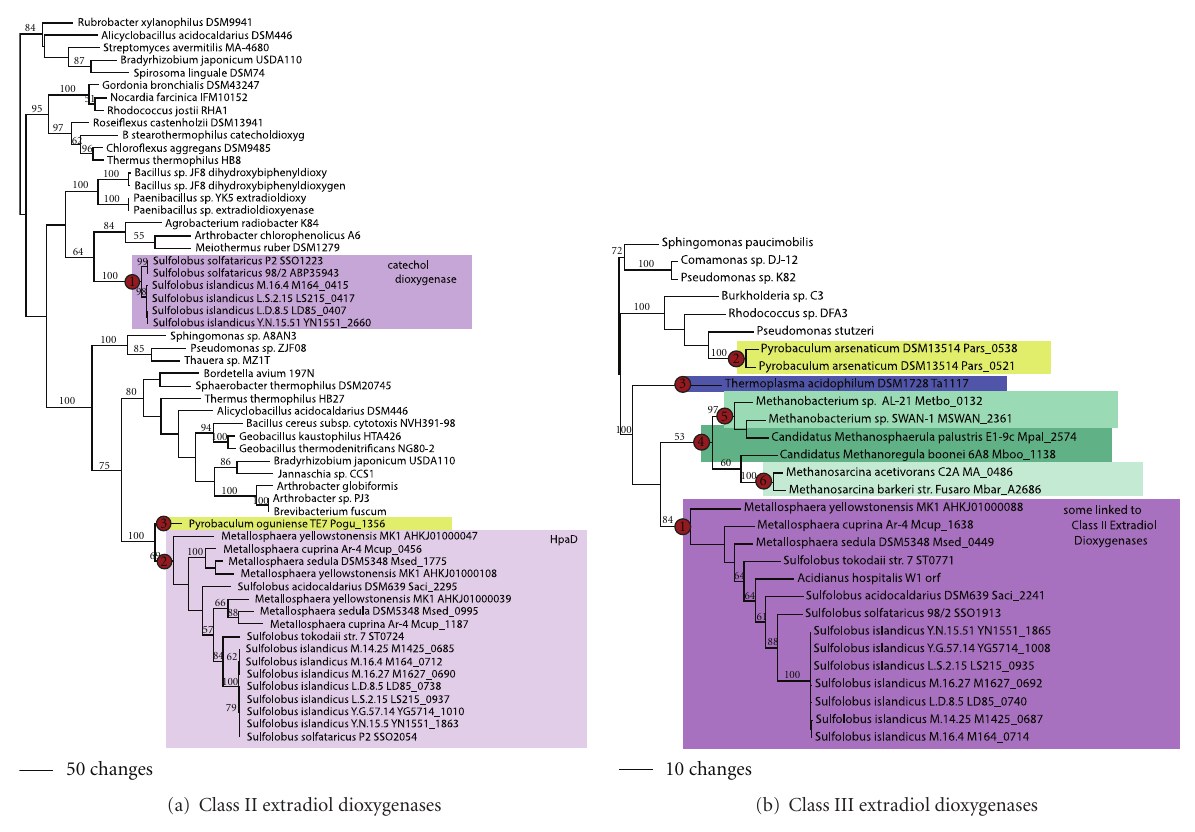
Figure 15: Extradiol dioxygenases. Phylogenetic trees for (a) class II extradiol dioxygenases and (b) class III extradiol